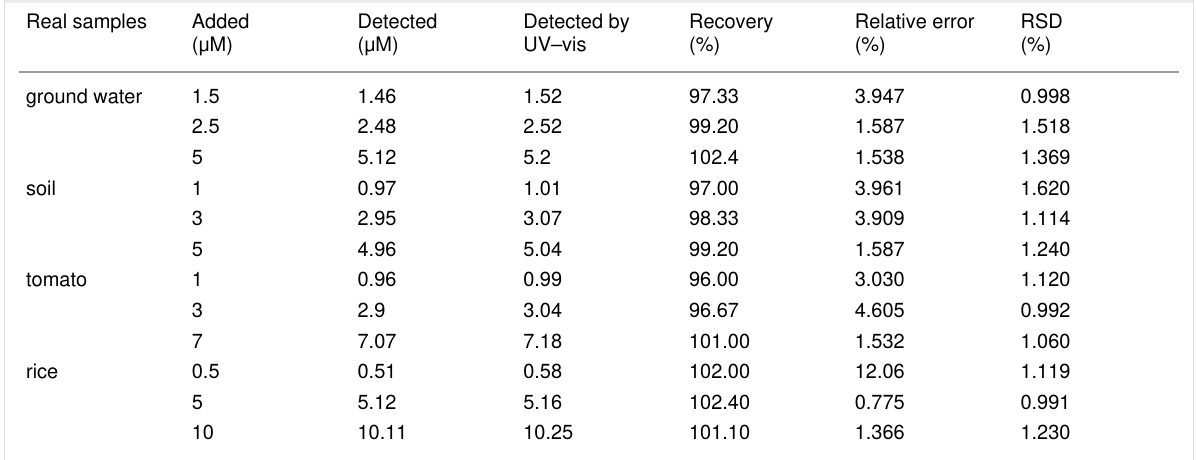
Table 3: Experimental sample table for recovery studies of spiked PT in actual samples. Real samples